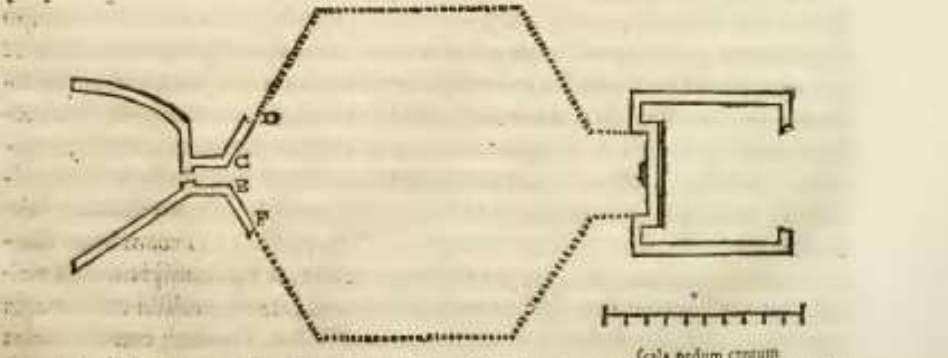
Figure 4. Plan of the Roman incile realized by R. Fabretti in Descrizione dell’emissario del Fucino 1683 [25].